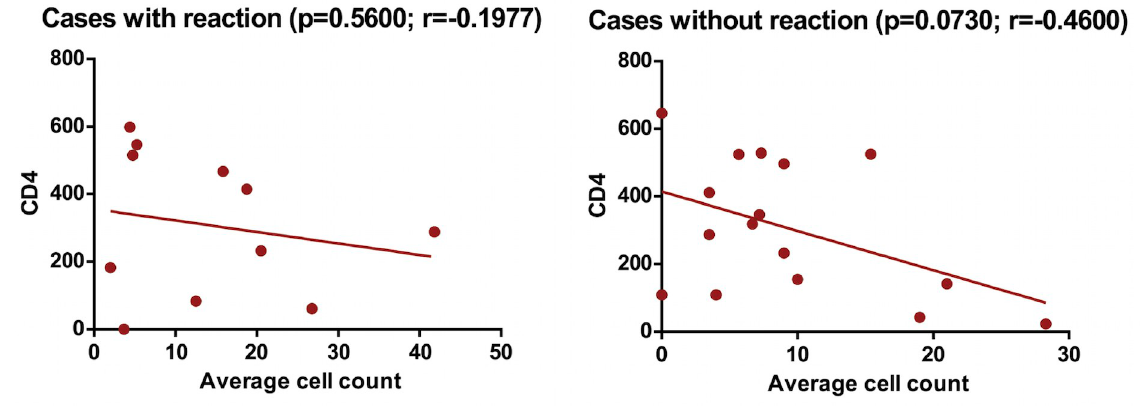
PLOS NeglectedTropical Diseases | https://doi.org/10.1371/journal.pntd.0009887 November8,